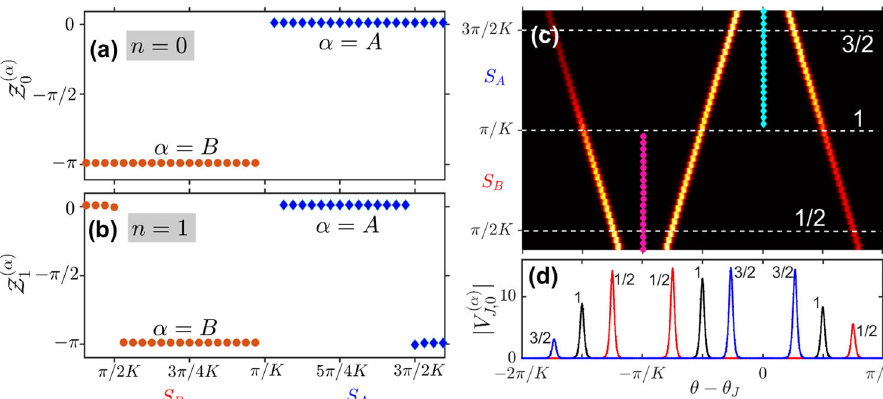
Fig. 3 Geometrical (Zak) phases and Wannier functions in soliton metacrystals. a , b Numerically computed Zak phases for the n = 0 (a) and n = 1 (b) bands. The phases fl ip by π at the band-crossing points, cf. Fig. 2d. c The change of the positions and relative strength of the peaks of the n = 0 Wannier function vs the soliton separation, S α , and θ − θ J (restricted to the one and a half unit cell length to boost resolution). The black-orange colour-map shows = K from ( a ). d shows three selected pro fi les of j V ð α Þ j V ð α Þ J ; j , see Eq. m.19. The magenta ( α = B ) and blue ( α = A ) vertical doted lines mark the values of Z ð α Þ J ; 0 j 0 0 for S α marked by the white horizontal lines in ( c α Þ = K and the Fig. 3c,d are explicit about the matching between Z ð 0 geometric centres of the Wannier functions. Recent papers demonstrating measurements of the geometric phases of cold atoms in optical lattices 66 and light in waveguide arrays 67,68 have applied various practical methods to detect positions of the respective wave-packets.